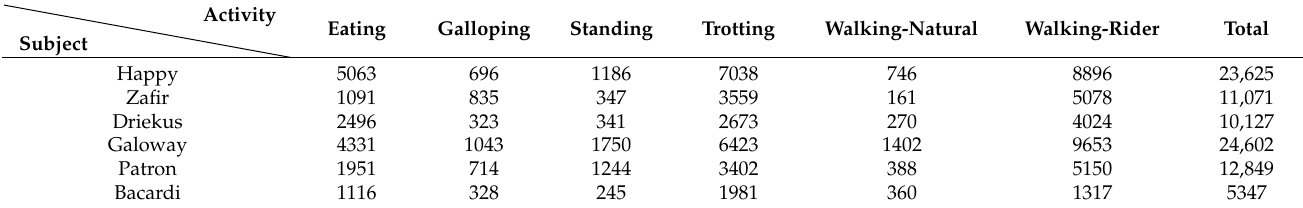
Table 1. Number of data samples per subject and